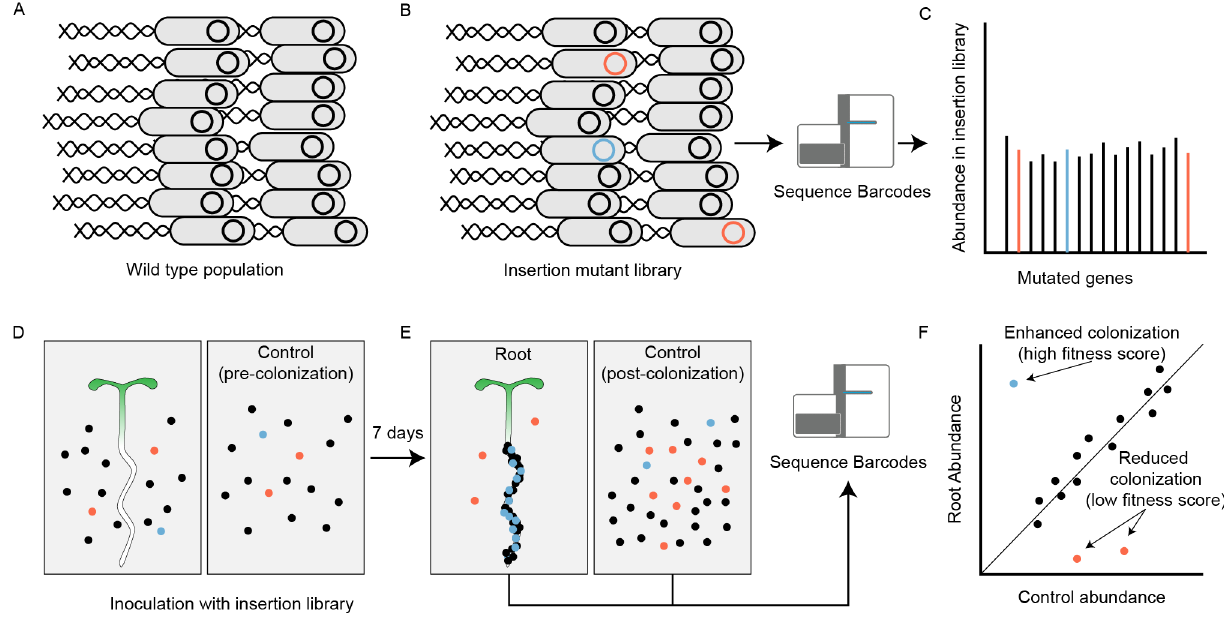
Fig 1. Overview of root colonization randomly barcoded transposon mutagenesis sequencing (RB-TnSeq) screen. Wild-type Pseudomonas simiae WCS417r (A) was mutagenized with a mariner transposon system, generating110,142insertionmutants (B). Most insertionmutations do not significantly alter the growth phenotype on the root (black), whilesome insertionmutations make these mutant strains more (blue) or less (red) likely to colonizeplant roots, while not significantly affecting their ability to grow in liquidculture or on the nylon substrate in the absenceof plants (C). This mutant strain library was exposedto vertically-oriented phytagel plates with (D, left) or without (D, right) Arabidopsisthaliana seedlings. After colonization, survivingmutant strains from the root and from the plant-freemesh were collectedand the abundance of insertionmutant strains within each populationwas quantified by RB-TnSeq. (F) Genes with under-represented insertion counts in the root populationcomparedwith the control population (shown here in red) were given low fitness scores (efficient colonization), while geneswith over-represented counts were given high fitness